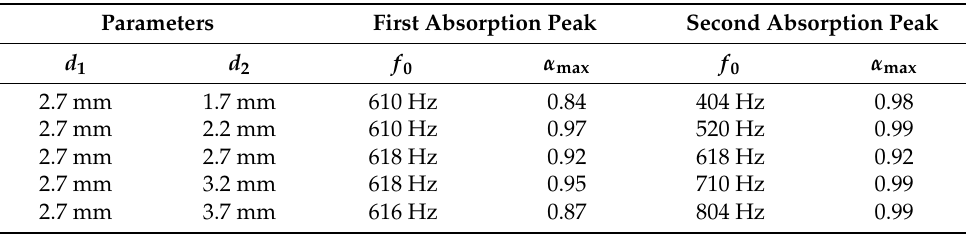
Figure 4. The influence of the diameter of the aperture to sound absorption performance of the double resonators in simulation. Table 1. A summary of the peak sound absorption coefficient α max and resonance frequency f 0 for double resonators with different diameter of the aperture.